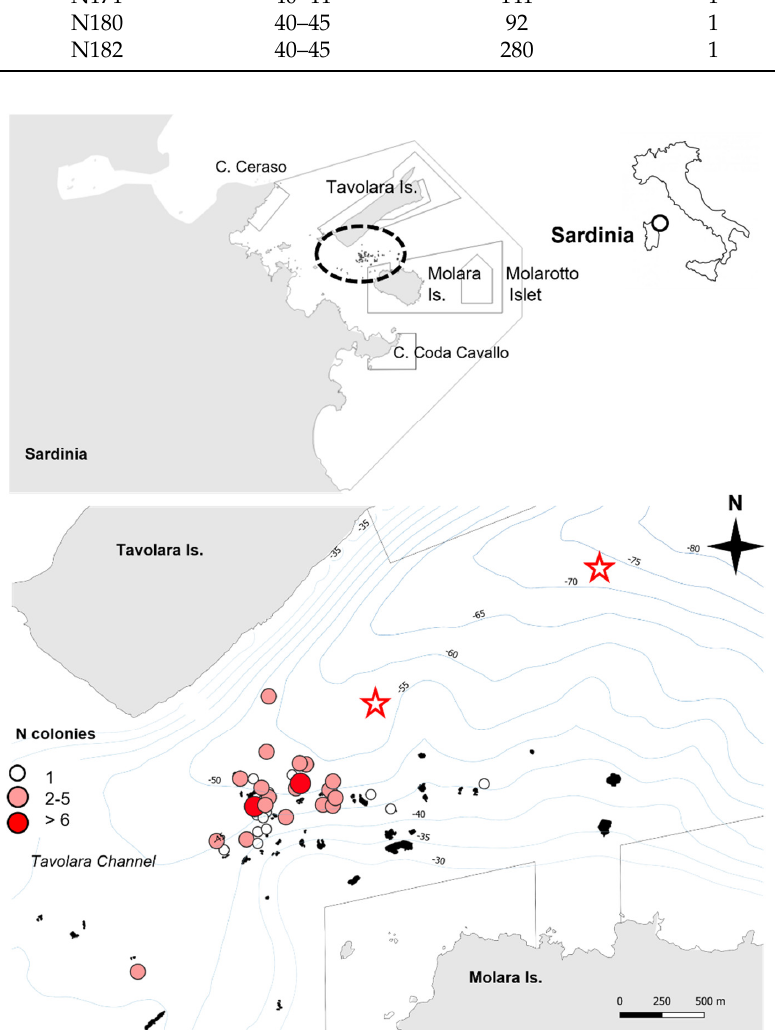
Figure 1. Location of the Tavolara–Punta Coda Cavallo Marine Protected Area and investigated sites (black polygons) with the indication of the number of Eunicella verrucosa colonies per site. Stars refer to ANDROMEDE [30,31] reports. Table 1. Investigated sites with the occurrence of Eunicella verrucosa within the Tavolara–Punta Coda Cavallo Marine Protected Area and number of specimens in each one. Coordinates of the sites can be consulted upon request to the Marine Protected Area repository.